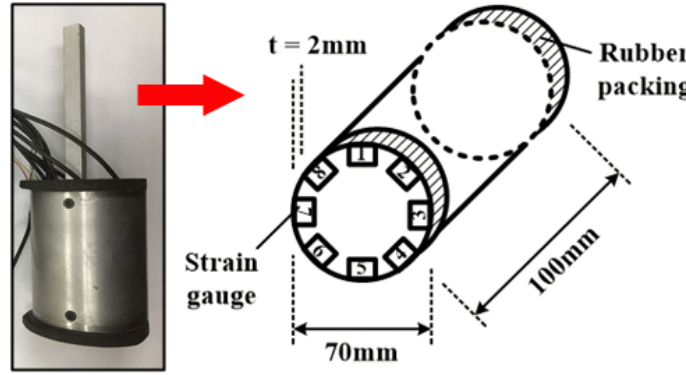
Figure 5. Model of tunnel.